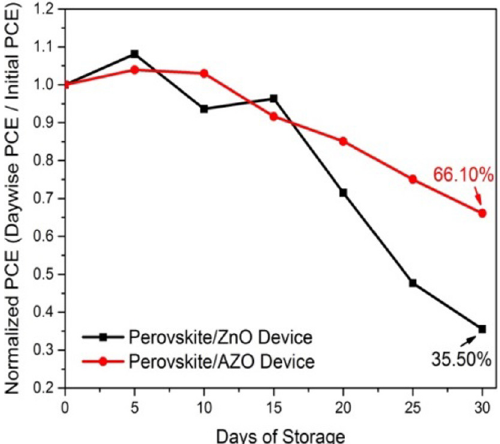
Fig. 3. 30 Days normalized PCE of MA 0.6 FA 0.4 PbI 3 /ZnO and MA 0.6 FA 0.4 PbI 3 /AZO devices attained from a systematic stability study. MA 0.6 FA 0.4 PbI 3 /AZO devices retain higher normalized PCE compared to MA 0.6 FA 0.4 PbI 3 /ZnO devices.